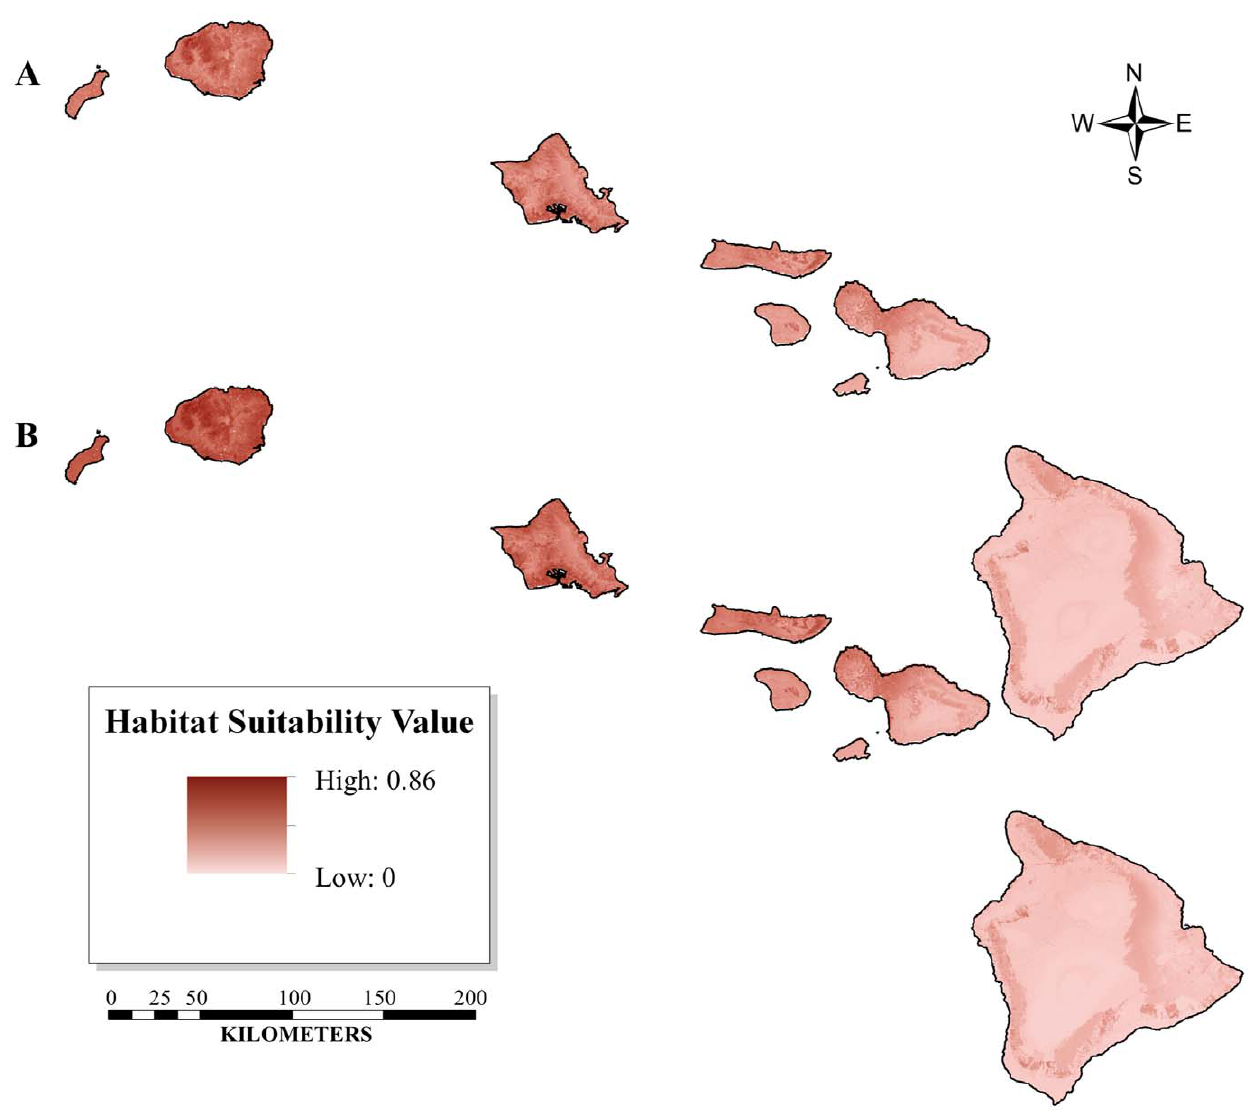
Figure 3. The Ecological Niche Models (ENM) defined in Maxent showing the distribution of O.continuatialis as collected from 1892 to 1967 and projected onto a set of biotic and abiotic variables. The figure shows the historically defined ENM (A) along with that of the ENM projected 2050 (B). The 2050 GFDL 2.1 climate change model was used to derive projected future climate variables. As compared to the historic distribution (A) the 2050 projected distribution of historic data (B) shows an expansion of suitable habitat area (see Table 4). Although the trend of habitat expansion is similar to the contemporary (current and projected) models, the overall model prediction differs significantly (Table 2).